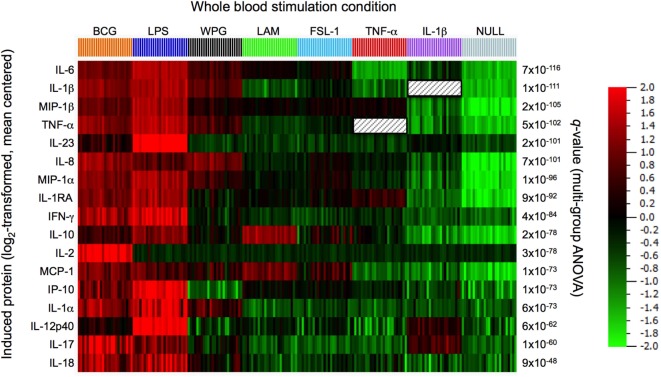
Comparison of protein responses induced by bacillus Calmette–Guérin (BCG) and its agonist ligand components. Clustering was performed on the data set obtained from 22 h whole-blood stimulation by BCG (3 × 105 CFU), lipopolysacharride (LPS, 10 ng/ml), whole protein glucan (WPG, 40 µg/ml), lipoarabinomannan (LAM, 10 µg/ml), the synthetic lipoprotein Pam2C (FSL-1, 2 µg/ml), tumor necrosis factor-alpha (TNF-α, 10 ng/ml), interleukin 1-beta (IL-1β, ng/ml), and buffer control (null condition). A heat map is shown, samples ordered by stimulation and protein features hierarchically clustered using the 17 most differentially induced proteins as defined by ANOVA (filtered to include analytes with q value < 0.01).